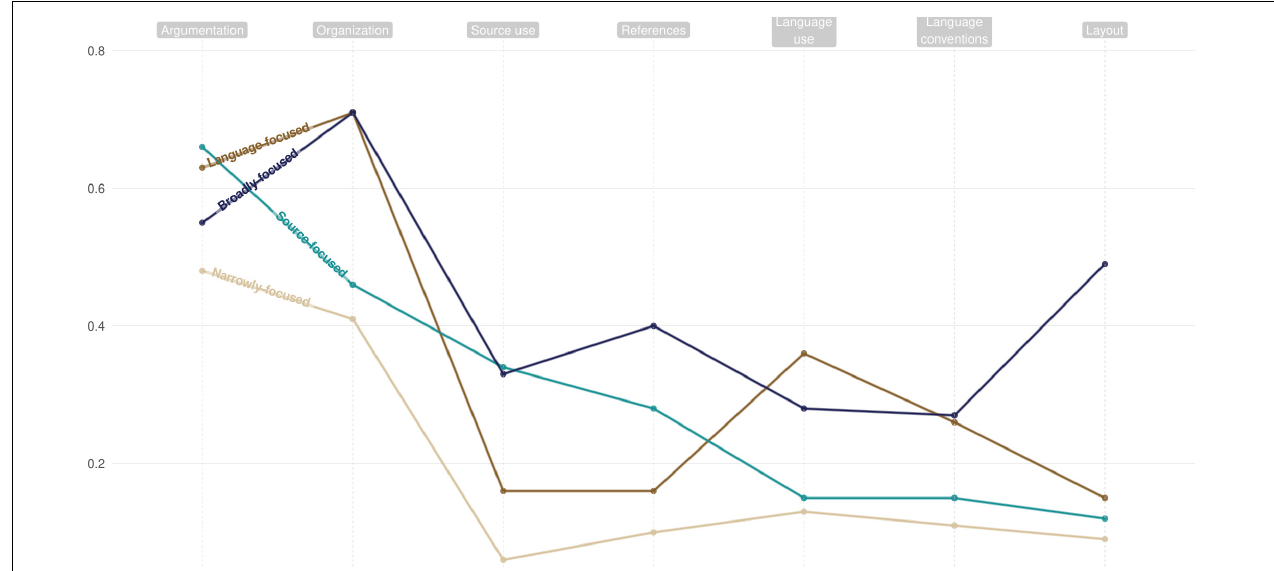
FIGURE 1 | The probability that a class referred to an aspect of text quality in a decision